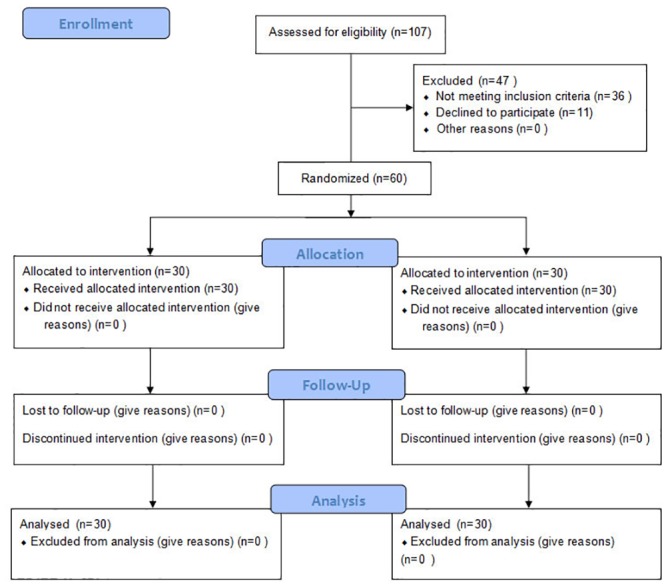
Trial flow chart.